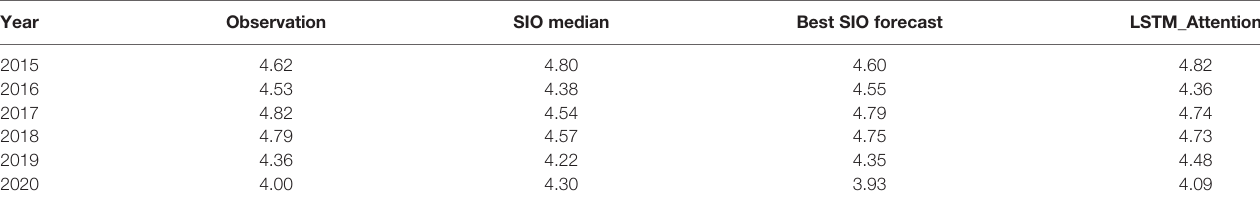
TABLE 2 | Values of the observations, the SIO contributions (August report of SIO median and the best SIO forecast), and the LSTM_Attention 1-month lead forecast for September monthly mean pan-Arctic SIE in the year 2015 – 2020 (unit: 10 6 km 2 ).